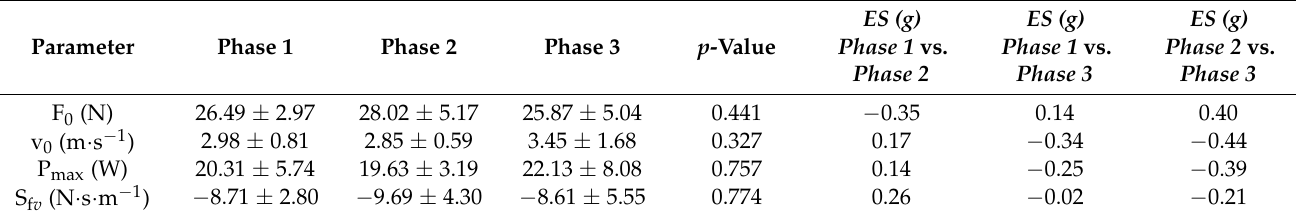
Table 2. Comparison of the F-v relationship parameters obtained from three different phases of the menstrual cycle during an incremental loading protocol for the countermovement jump (CMJ)